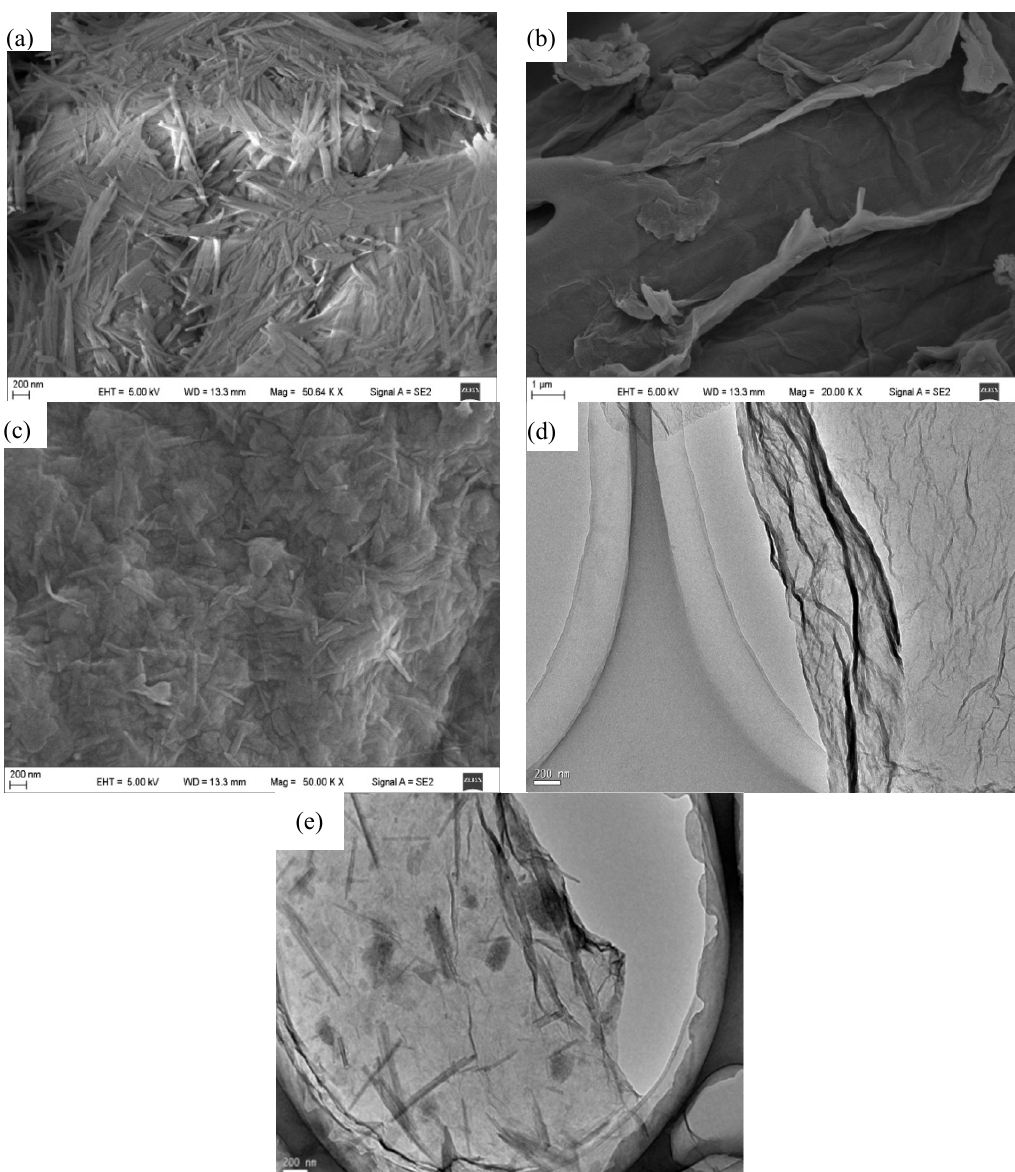
Figure 2. Scanning electron microscopy (SEM) and transmission electron microscopy (TEM) images of ( a ) ATP, ( b ) GO, ( c ) as-prepared GO and TEM images of ( d ) GO and ( e ) as-prepared GO.